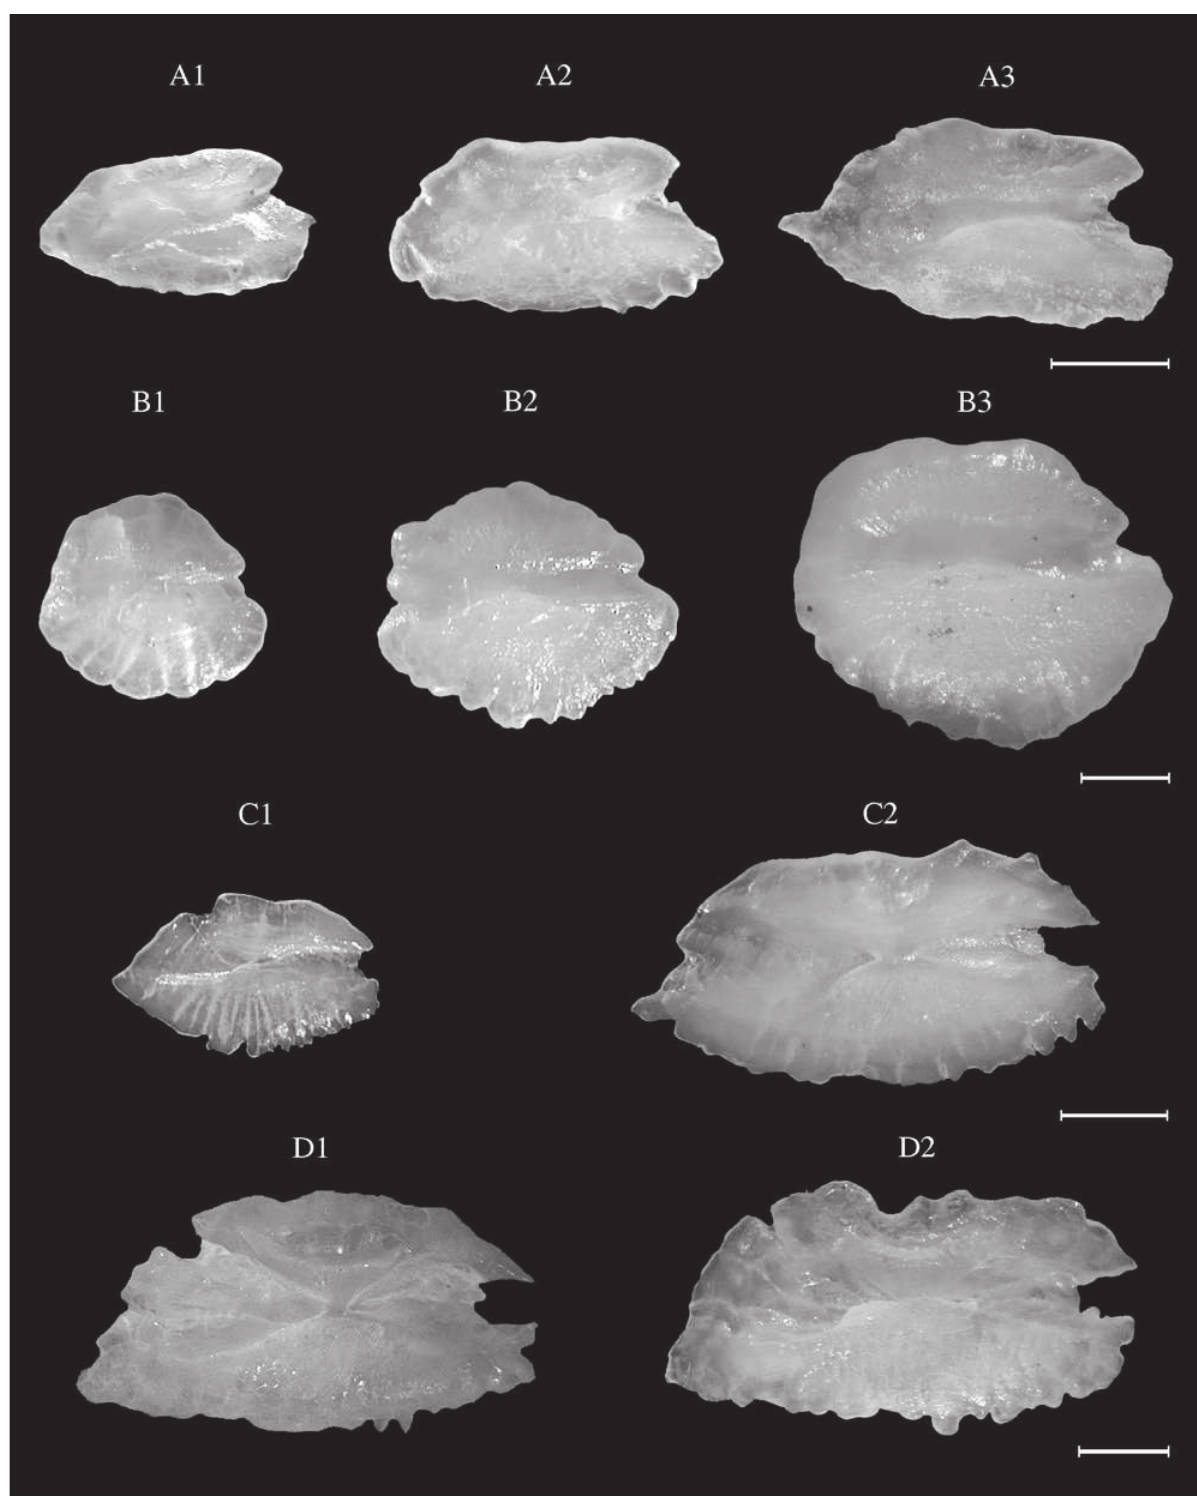
Fig. 72. – Thalassoma pavo . TL: A1, 9.2 cm (WM); A2, 15.9 cm (CEA); A3, 16.0 cm (CEA). Xyrichthys novacula . TL: B1, 12.5 cm (WM); B2, 15.5 cm (WM); B3, 19.5 cm (CEA). Sparisoma cretense (CEA). TL: C1, 14.3 cm; C2, 24.5 cm. Sparisoma rubipinne (CEA). TL: D1, 38.0 cm; D2, 38.0 cm. Scale bar = 1